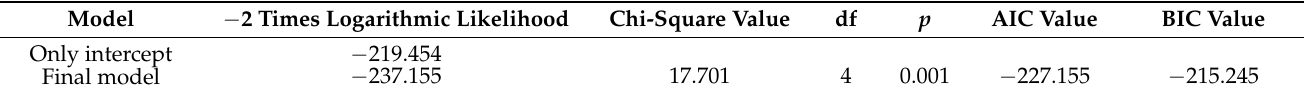
Table 9. Likelihood ratio test of Tobit regression